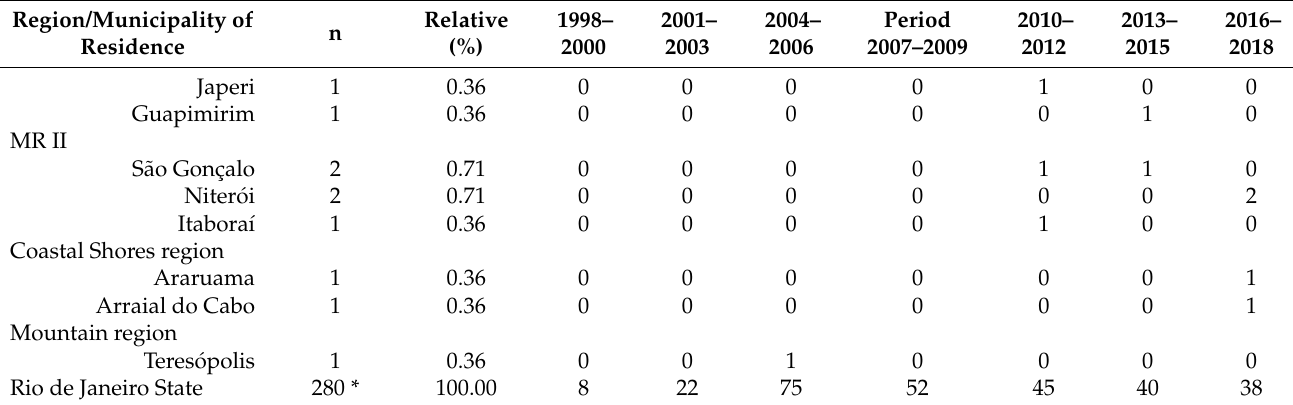
Figure 3. Kernel maps of the 249 canine sporotrichosis cases in the state of Rio de Janeiro, Brazil, over the periods studied. Figure 4 shows the kernel map of canine sporotrichosis for the georeferenced points over the total period from 1998 to 2018, highlighting the locations of greater occurrence.